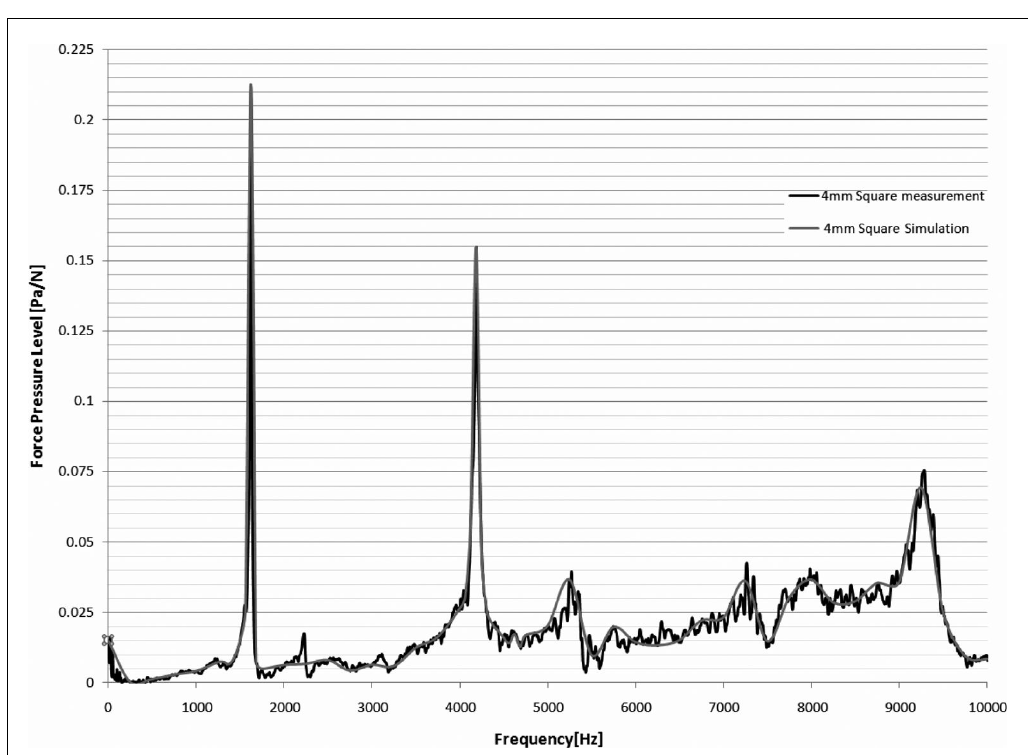
Fig. 73. 4 mm square EIDL – measurement Vs. simulation